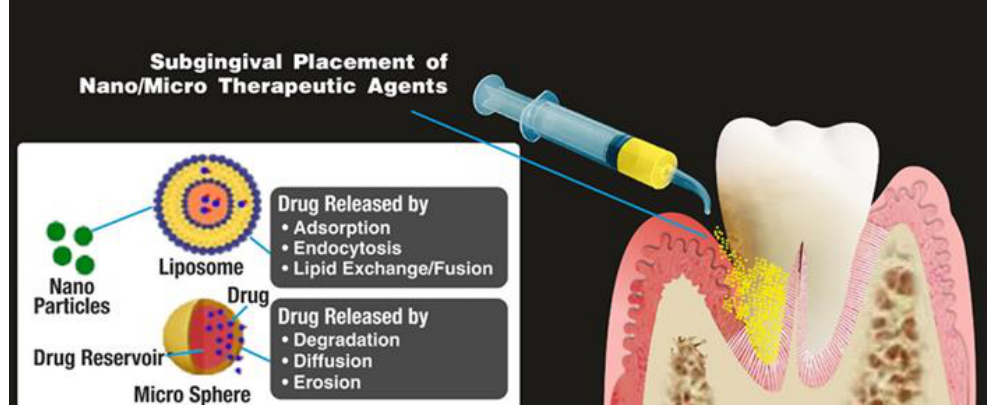
Figure 5. Microparticles and nanosystems and their placement, reproduced with permission from Rajeshwari et al. [32].